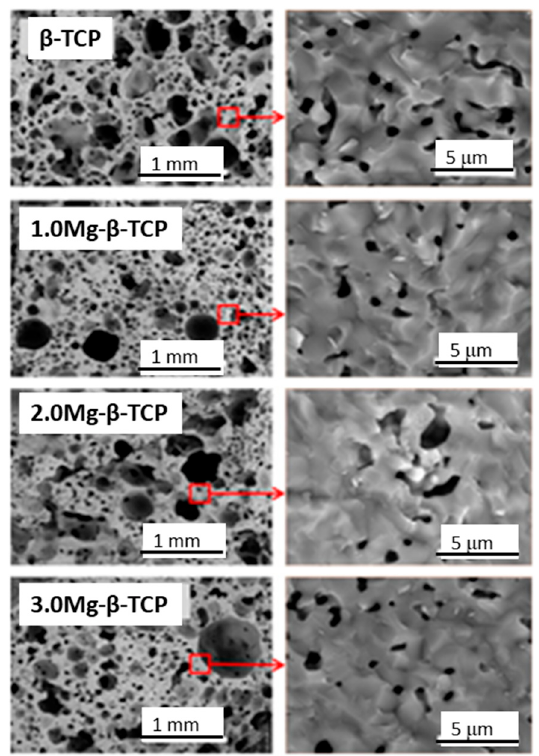
Figure 7. FESEM images Mg-containing micro-macroporous scaffolds fracture surfaces. Reprinted from [123] with permission from Elsevier.